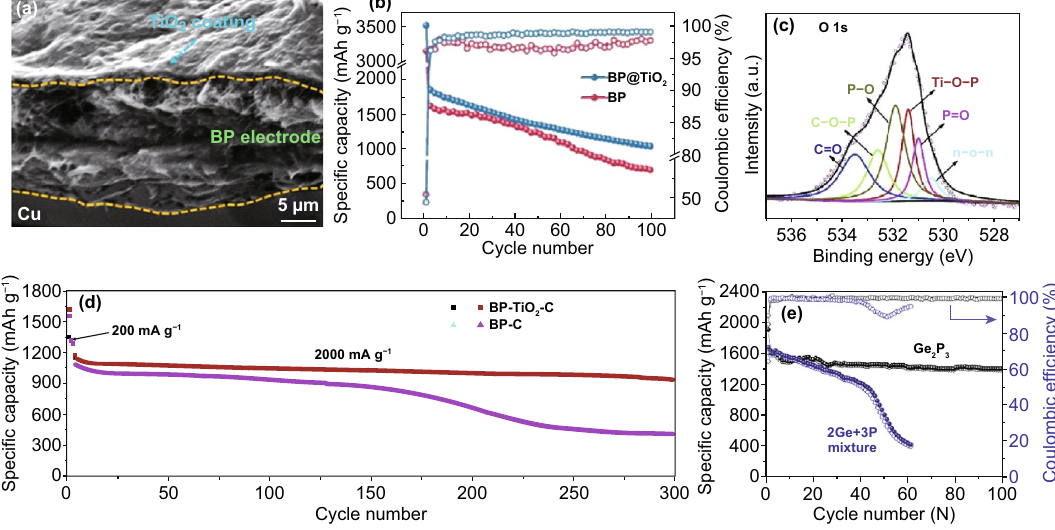
Fig. 9 a SEM and b cycling performance of BP@TiO 2 composite [146]. c XPS spectra of O 1 s of BP-TiO 2 -C composite, d the cycle perfor- mance of BP-TiO 2 -C and BP-C composite [147]. e The cycle stability of Ge 2 P 3 and 2Ge + 3P electrode [153]. Adapted from Refs. [146, 147, 153] with